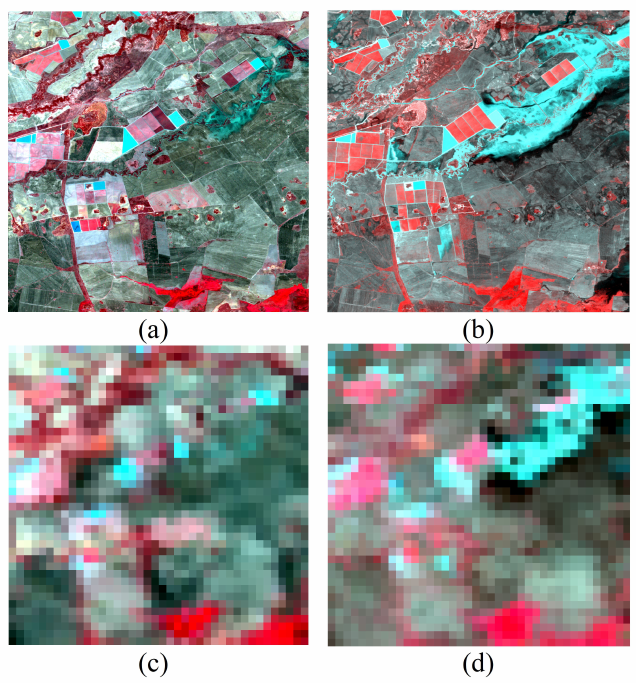
Figure 3. Test data with abrupt change (flood) in Gwydir. ( a ) Landsat image of 26 November 2004; ( b ) Landsat image of 12 December 2004; ( c ) and ( d ) MODIS images of the same periods to Landsat images. All images use NIR-red-green as